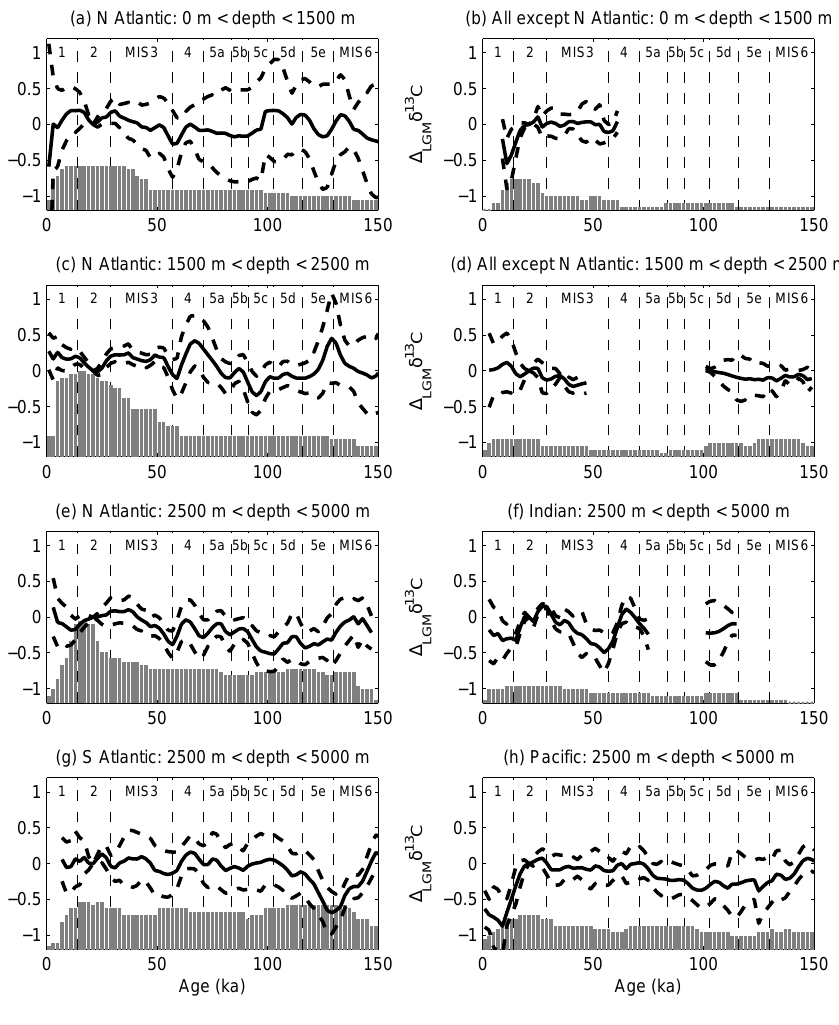
Fig. 9. Mean and 2 × standard error, weighted by the square of the inverse of the error estimate, of planktonic minus benthic 1 LGM δ 13 C ( 1 LGM δ 13 C p − b )in each region. Note that 1 LGM δ 13 C p − b was calculated for each record prior to averaging.